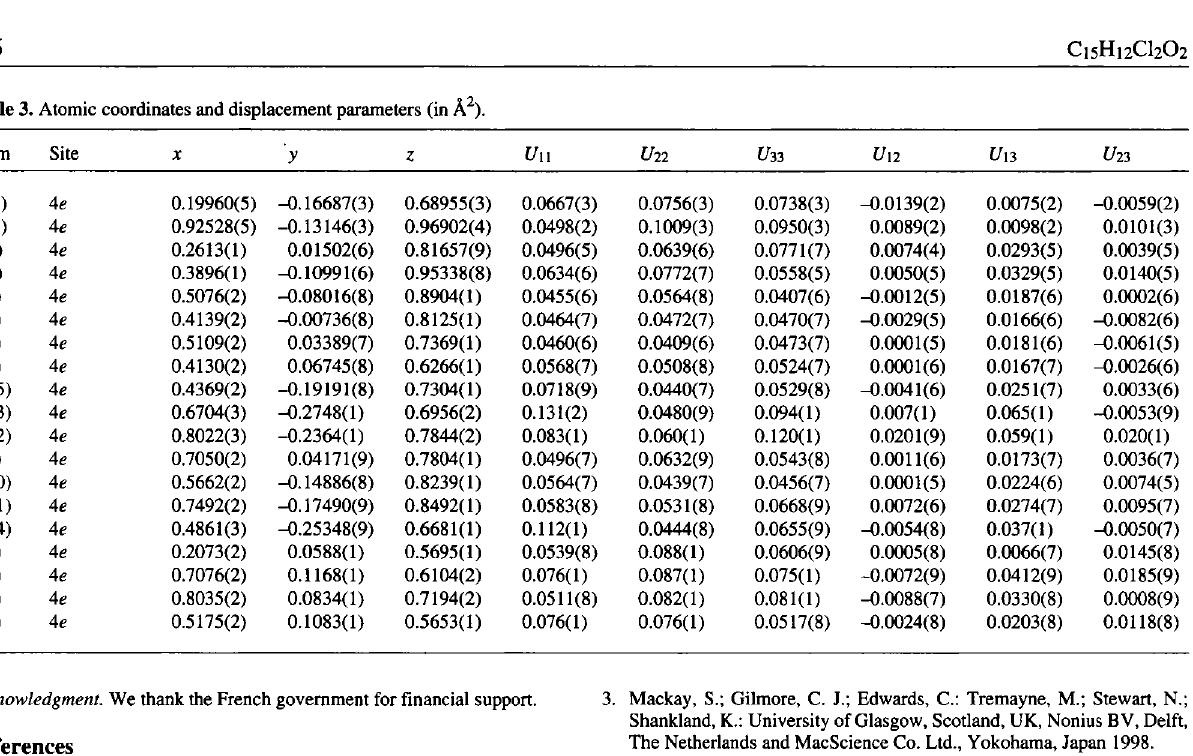
Table 3. Atomic coordinates and displacement parameters (in Ä 2